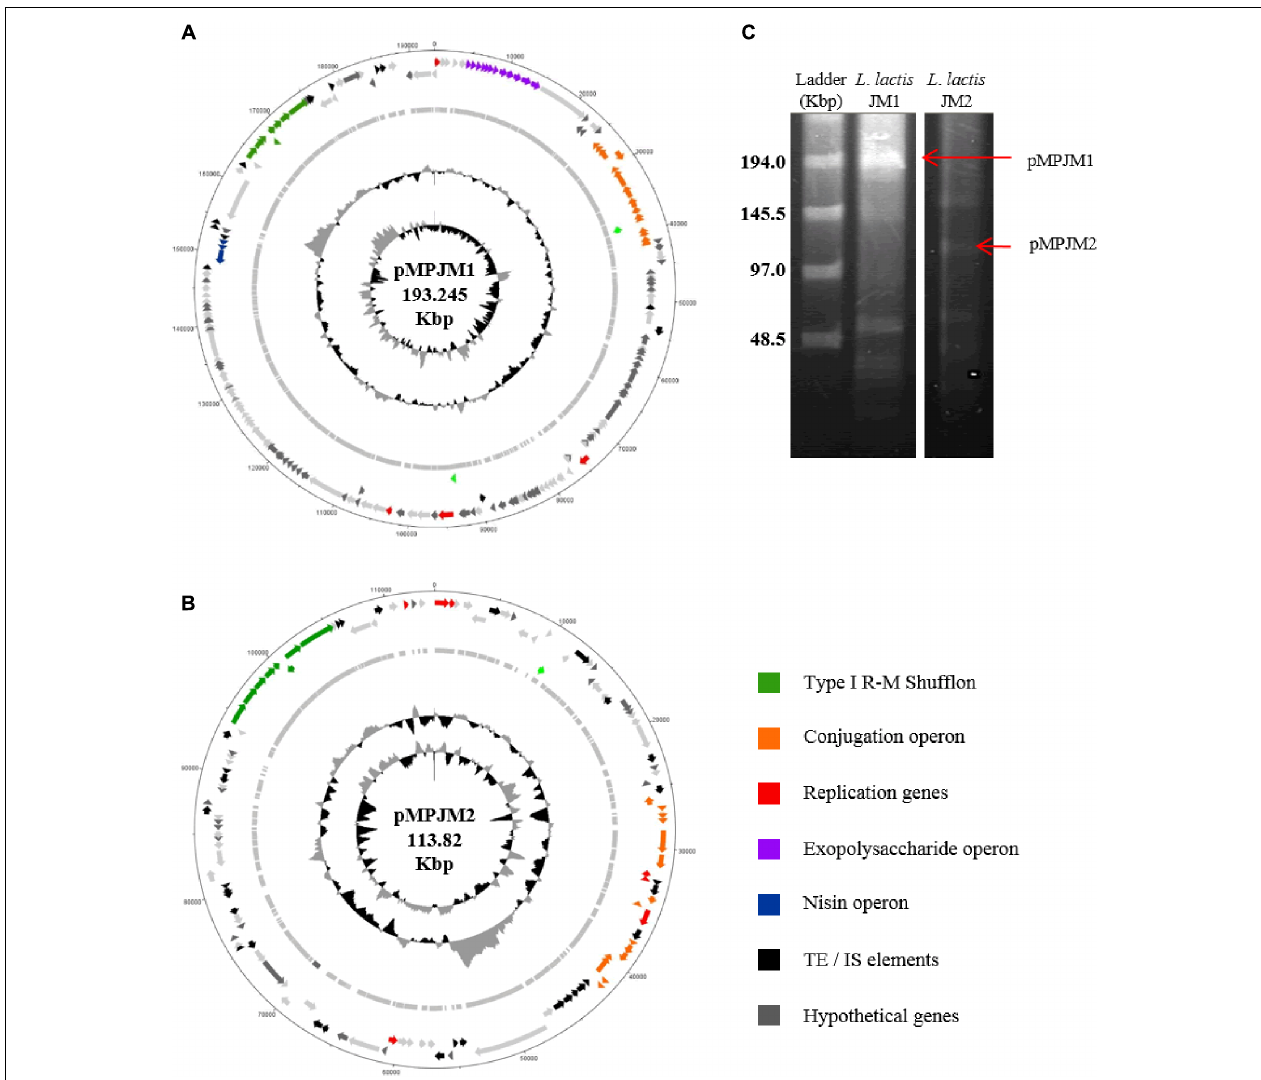
FIGURE 3 | General features of megaplasmids pMPJM1 and pMPJM2. Circular maps of (A) pMPJM1 and (B) pMPJM2. CDS of interest are highlighted in color. (C) PFGE image of pMPJM1 (lane 2) and pMPJM2 (lane 3), the possible position of each of the two megaplasmids is indicated by a red arrow. CHEF lambda (Bio-Rad Laboratories, Hercules, CA, United States) DNA ladder is displayed in lane